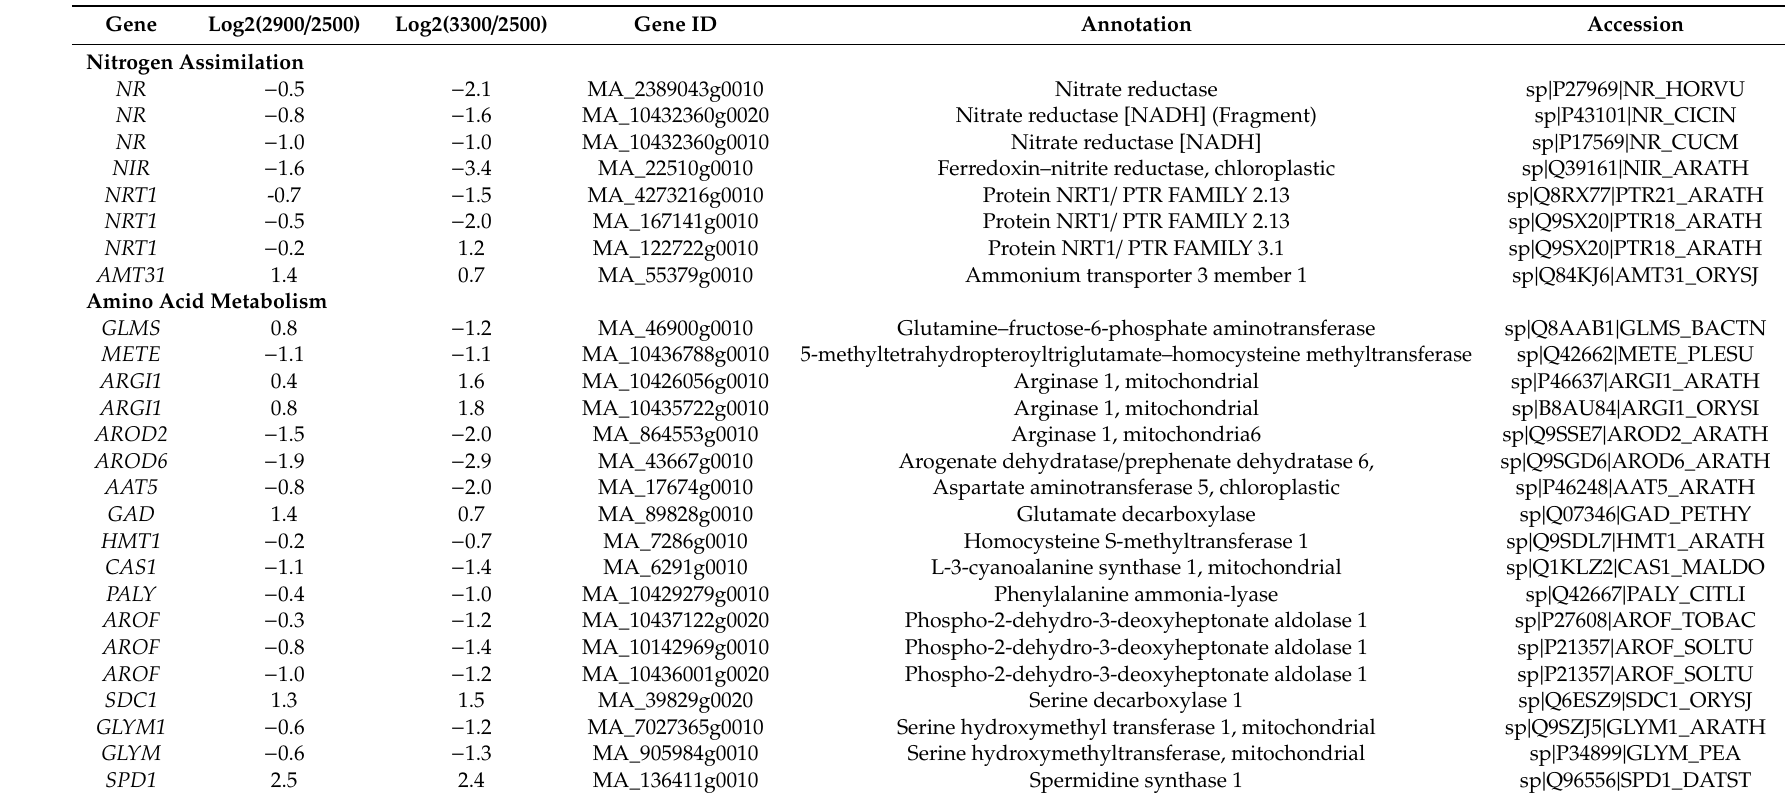
Table 3. DEGs involved in nitrogen